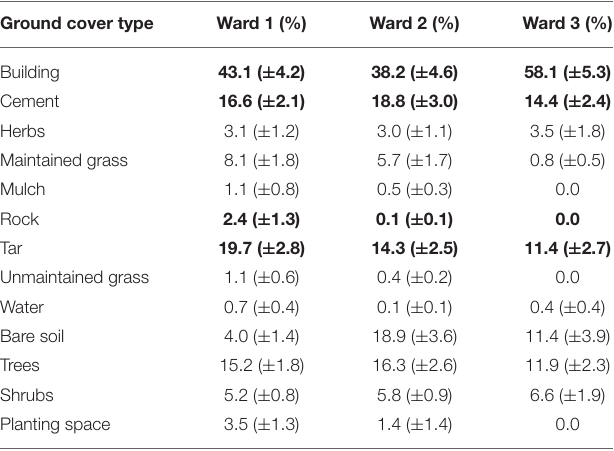
TABLE 4 | Ground cover type estimated for the three wards in the National District of Santo Domingo, Dominican Republic. Ground cover